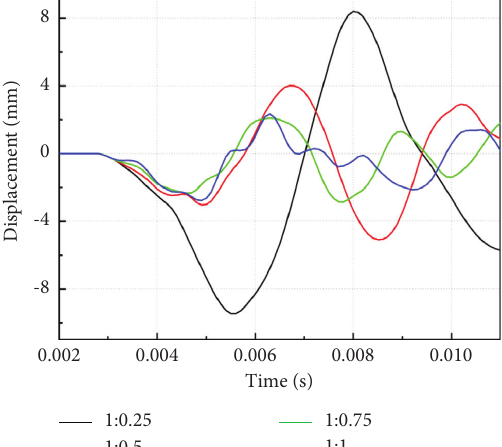
Figure 20: The mid-span displacement time history curve of the EBD with different diameter ratios.